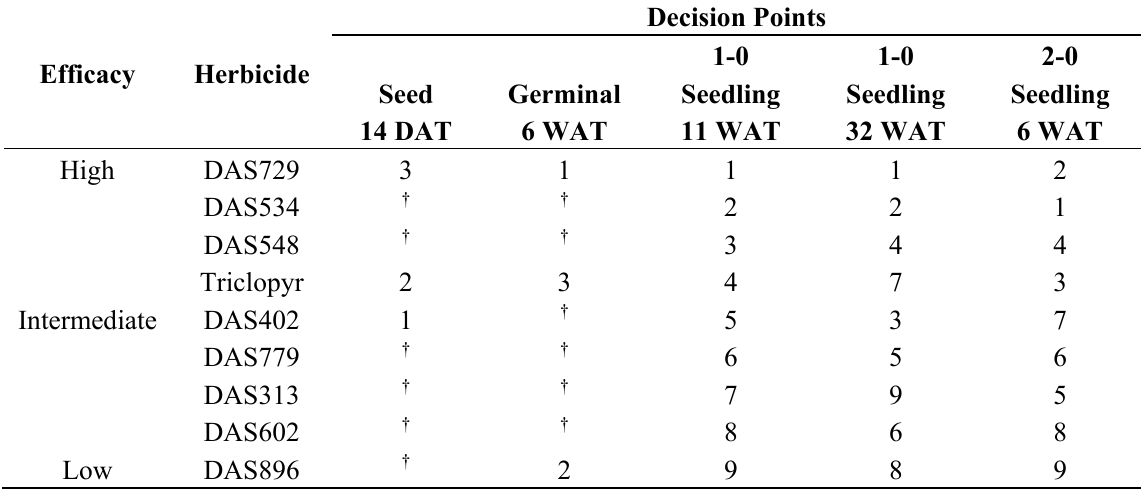
Table 6. Overview of herbicide rankings ‡ across screening